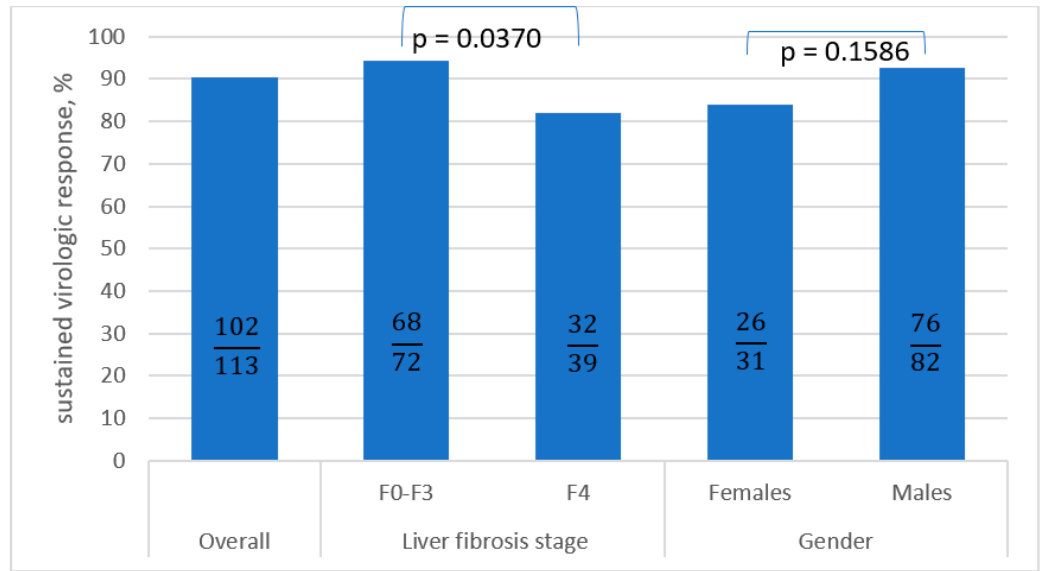
Figure 2. The comparison of SVR in the subpopulations calculated as PP analysis a . SVR: sustained virologic response; PP: per protocol; F: fibrosis. a Pearson’s chi-squared test was used.